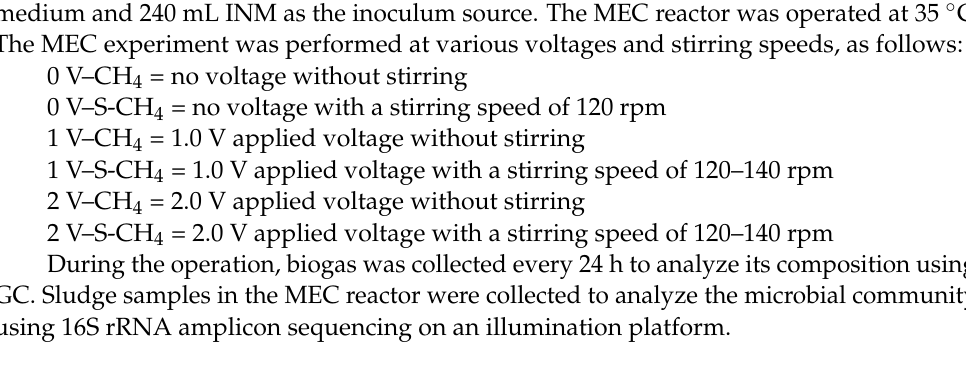
Table 3. Characteristics of the dark fermentation effluent from the continuously stirred tank reac- tor